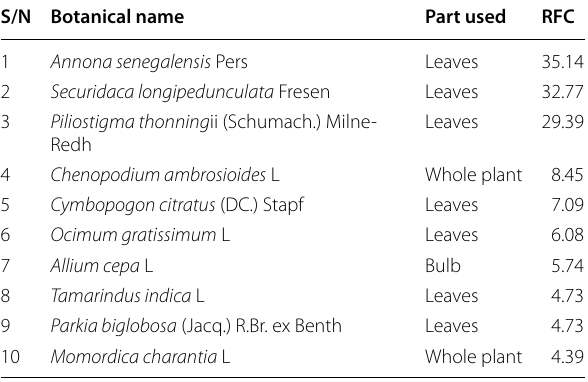
Table 5 List of plant species and parts used for preparing aqueous extracts for phytochemical screening S/N Botanical